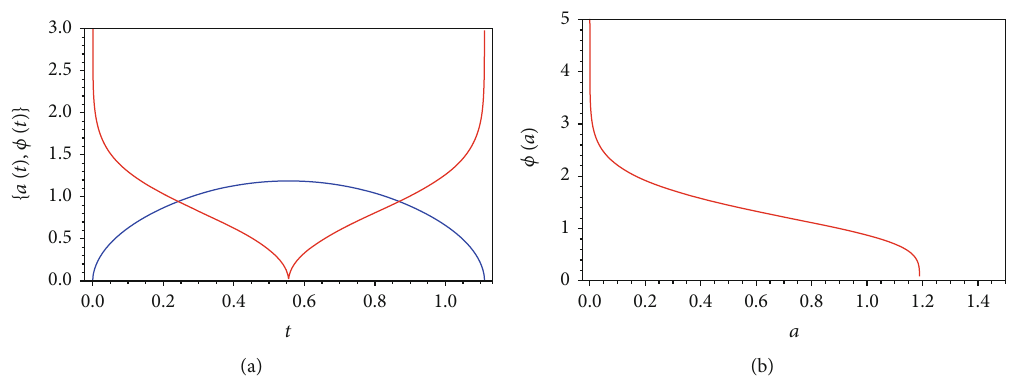
Figure 2: (a) The qualitative behavior of the scale factor (blue line) and scalar fi eld (red line) when Λ = 0 and g trajectory in the plane a − ϕ . The fi gures are plotted for the numerical values: g